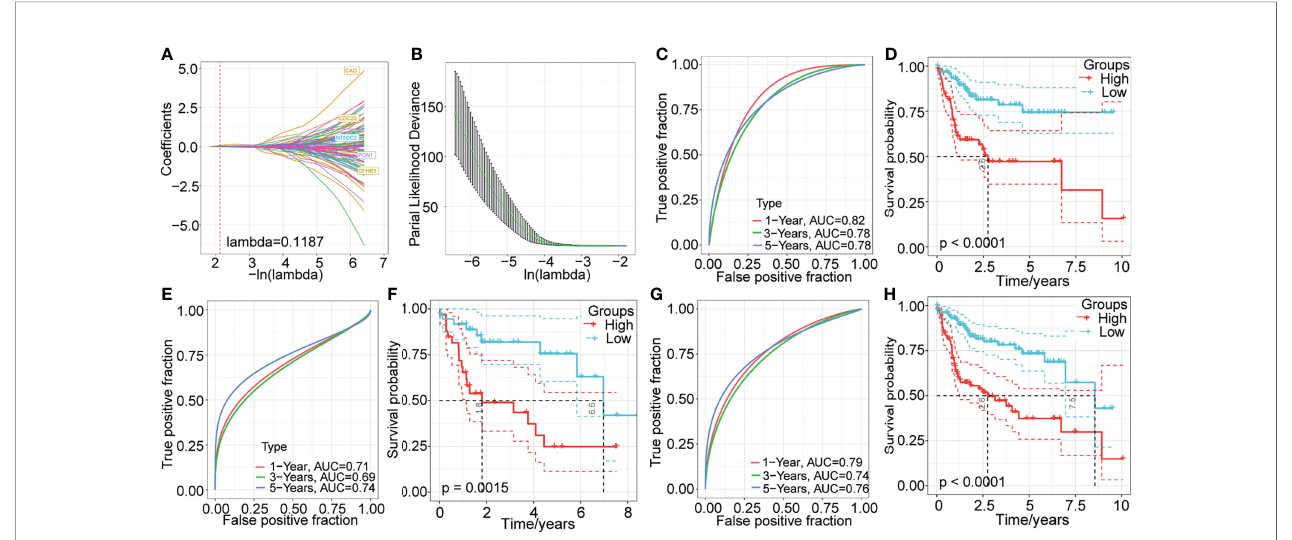
FIGURE 5 | Construction and validation of a prognostic model based on the DEGs between m1A-related gene clusters. (A) The change trajectory of each independent variable. (B) The con fi dence interval under each lambda. (C – H) Time-dependent ROC curve measuring the predictive value of the fi ve ‐ gene model in the TCGA training set, TCGA-LIHC validation dataset, and whole TCGA-LIHC dataset. Kaplan-Meier curves for overall survival by the 5-gene model in the TCGA training set, TCGA-LIHC validation dataset, and whole TCGA-LIHC